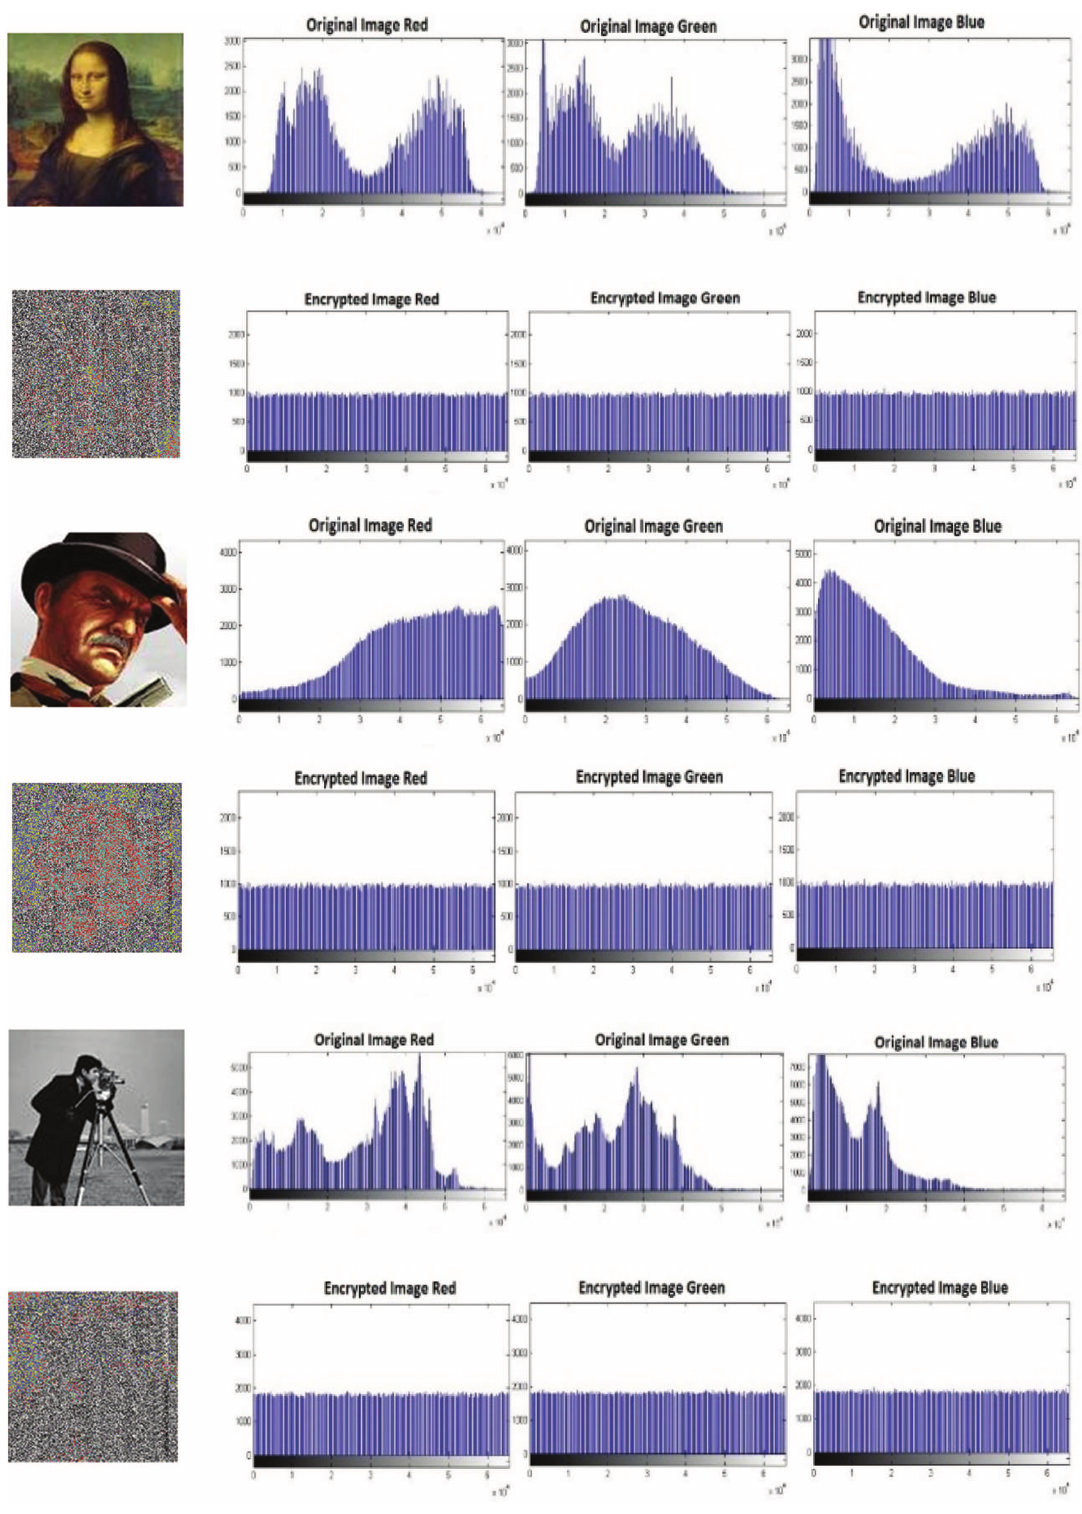
Figure 11: Histogram for Original Images and its